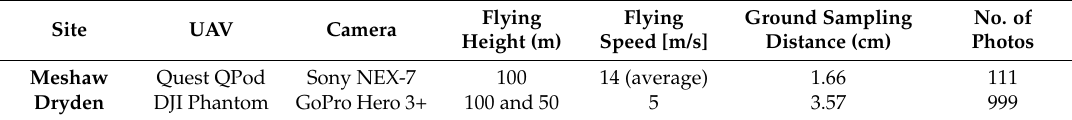
Table 1. Summary of UAV missions at the 2 sites. Both missions were fully autonomous missions where the UAV followed a way-pointed flight route over the field